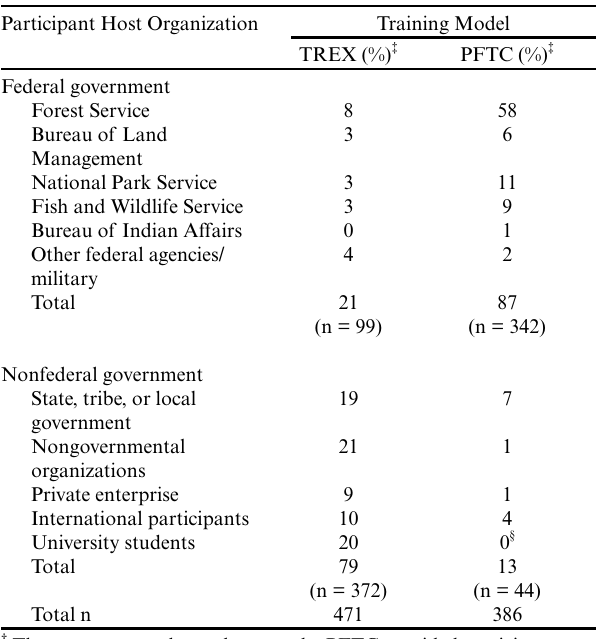
Table 1 . A comparison of participant agency affiliation between the Prescribed Fire Training Exchange (TREX) and the Prescribed Fire Training Center (PFTC) training models, 2011-2013.